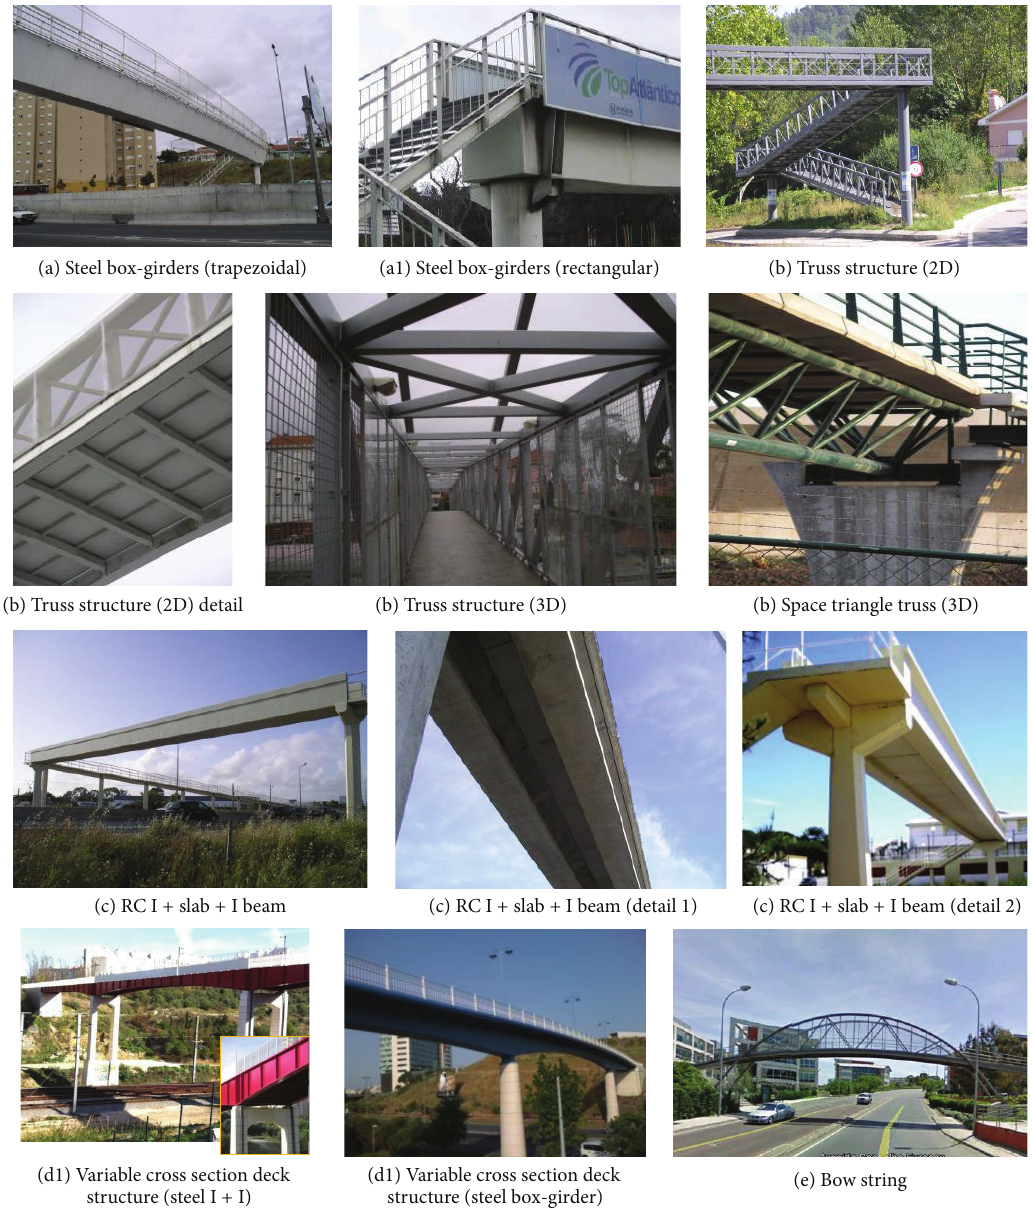
Figure 3: Main typologies of footbridges in